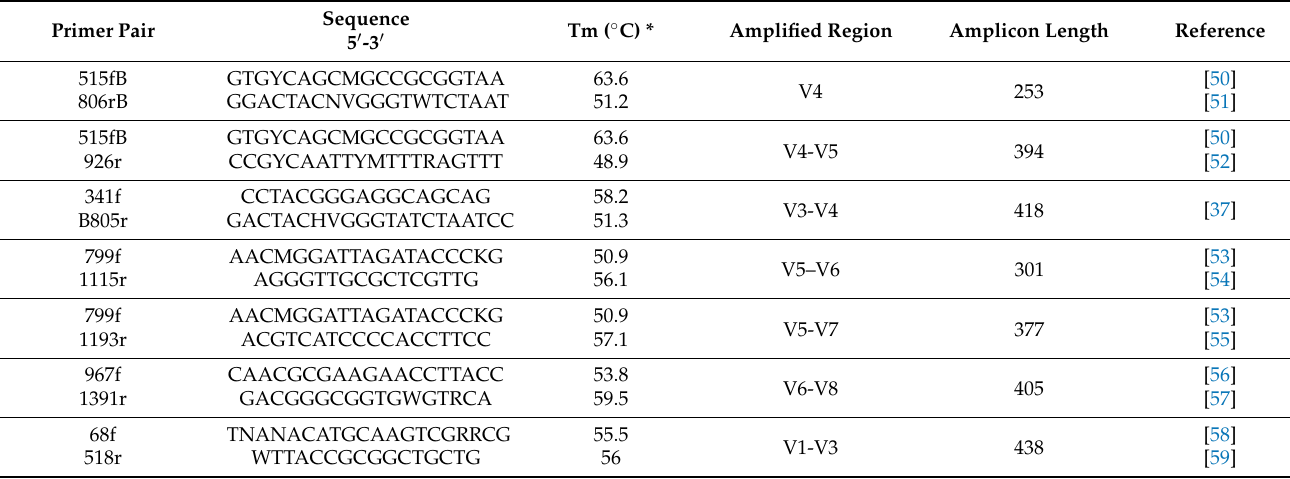
Table 2. Primer pairs targeting the 16S rRNA gene that have been frequently used to characterize Bacteria biodiversity in studies based on Illumina sequencing.